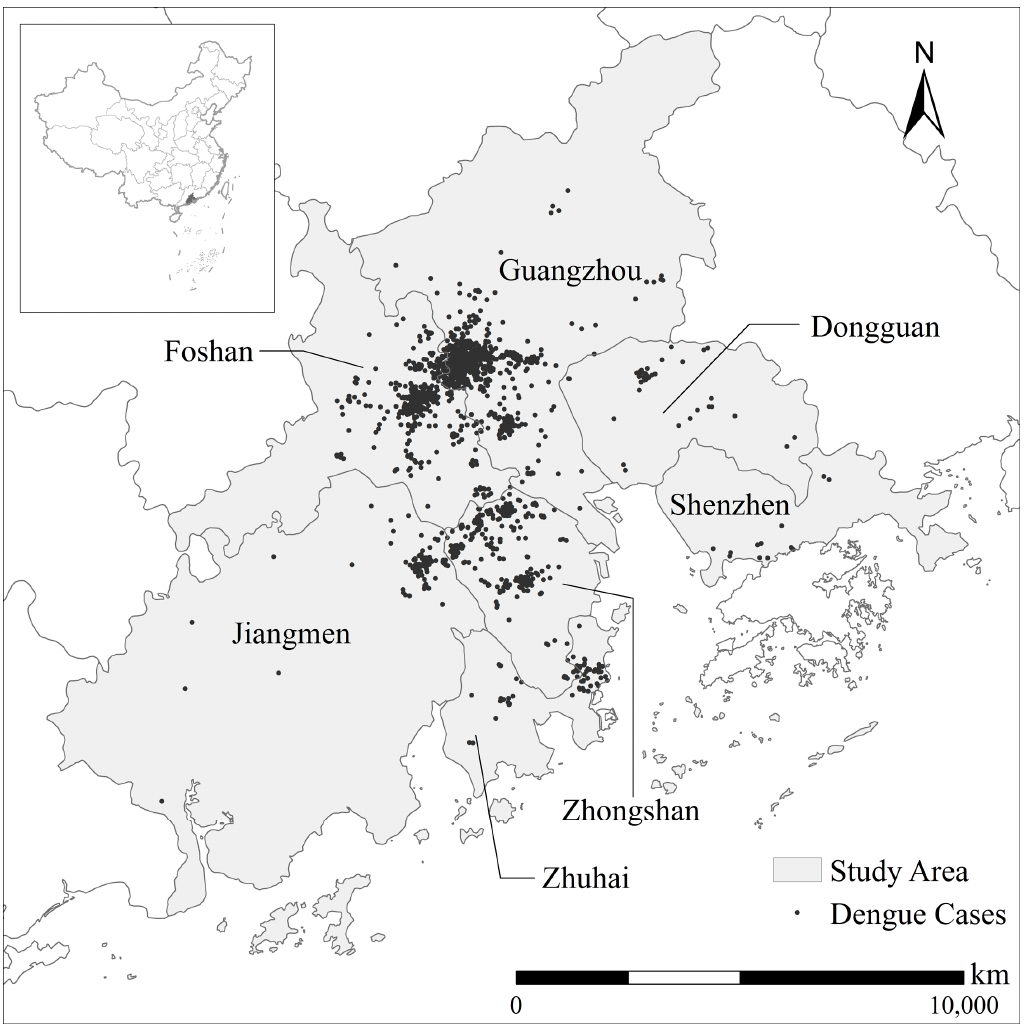
Figure 1. Recorded cases of dengue fever in the Pearl River Delta from 2003 to 2013.